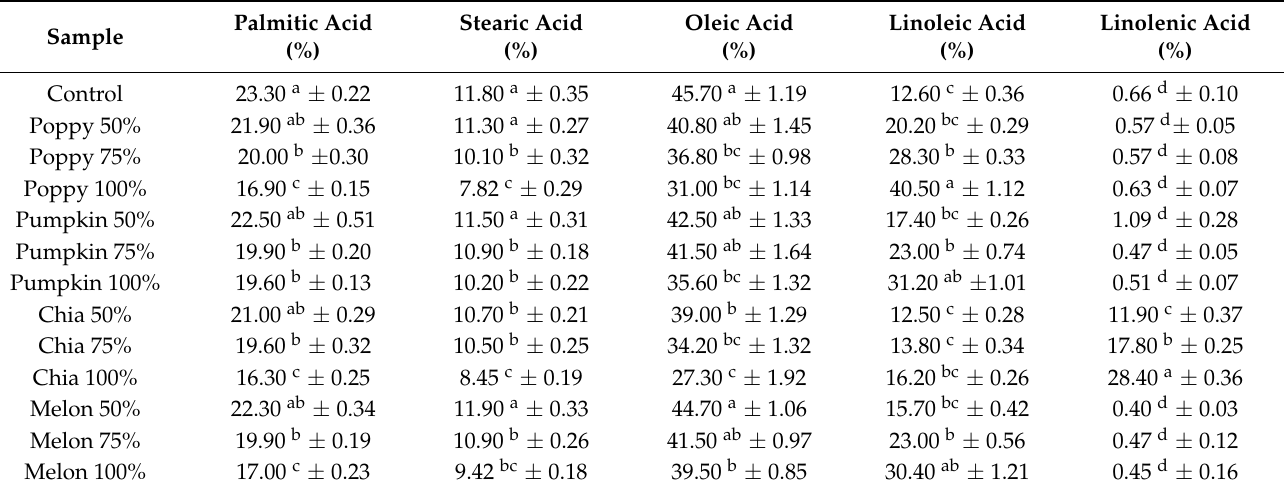
Table 4. Results for the composition of the main fatty acids of the fuet samples prepared using different emulsified seed